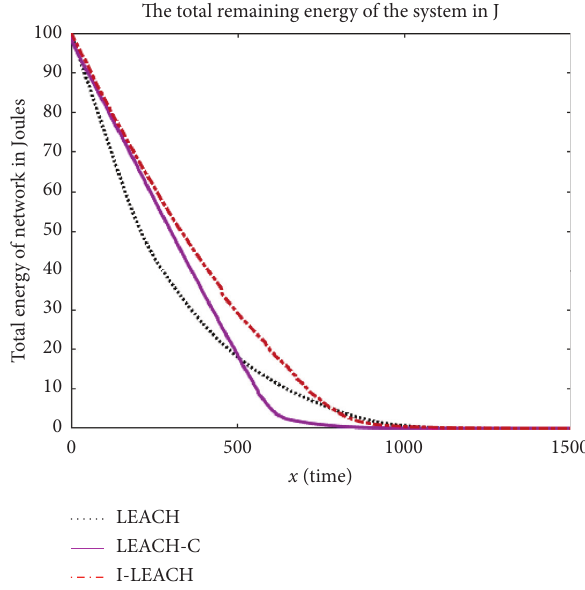
Figure 9: Residual energy of the network under the three